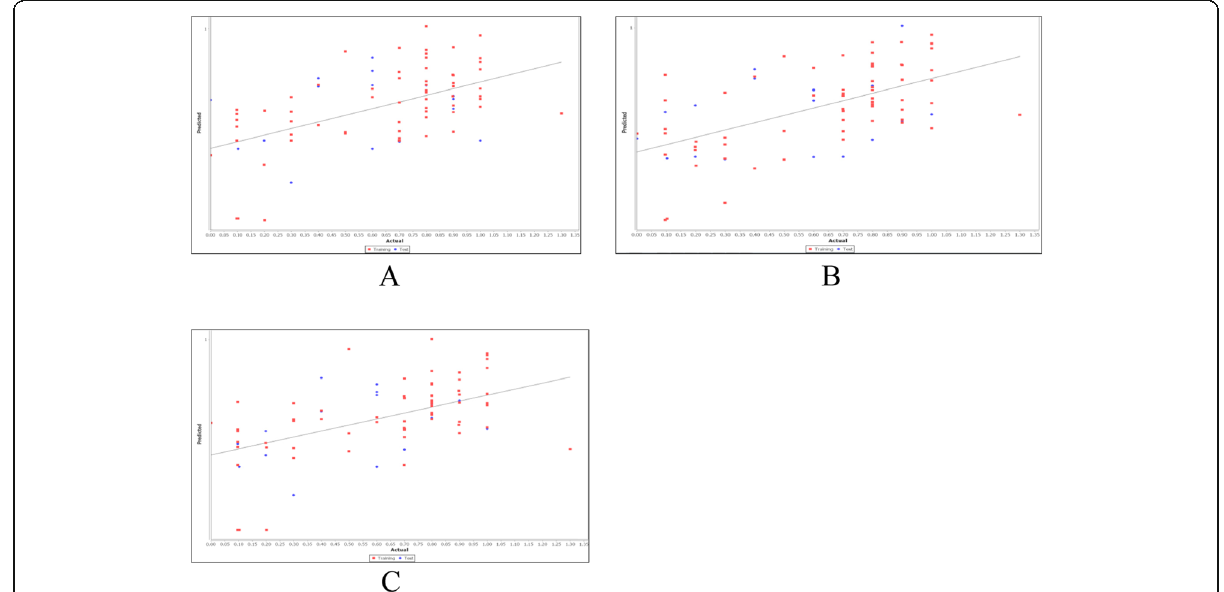
Fig. 4 a – c Fitness plot between training and test set compounds for model-I, model-II, and